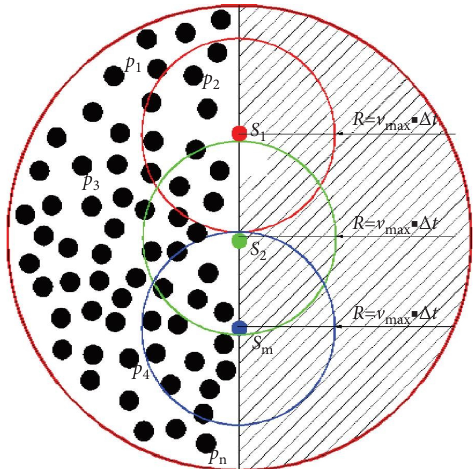
Figure 14: Schematic diagram of near-wall collision